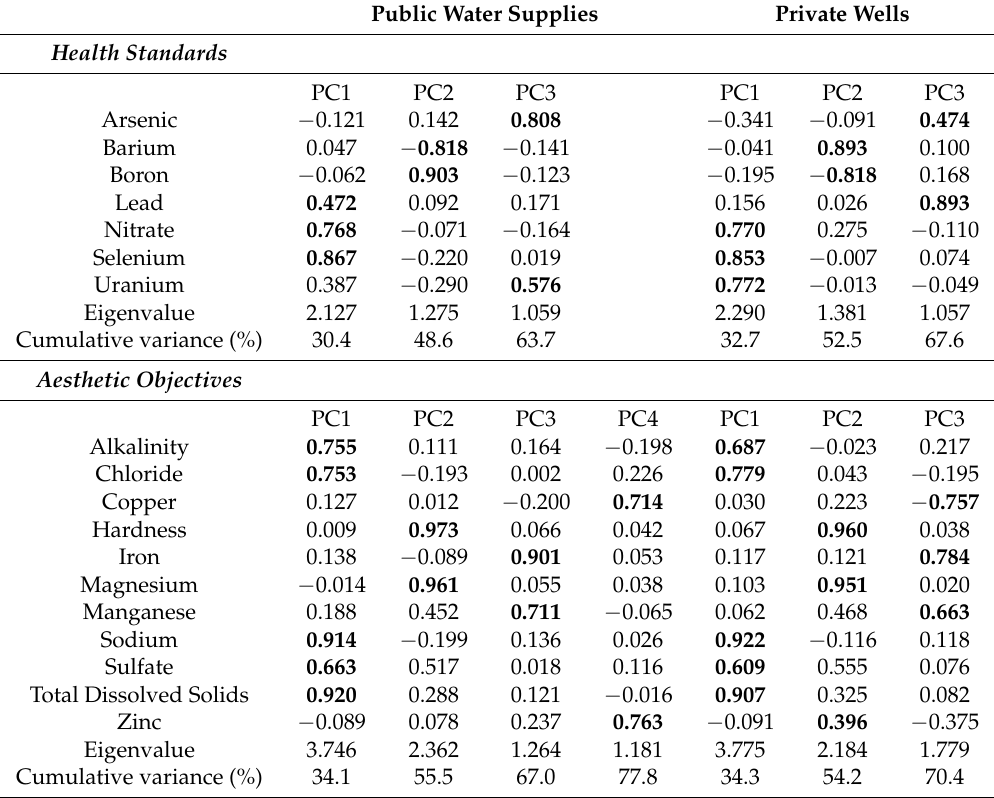
Table 4. Principal components analysis on public water supplies and private well water supplies: varimax rotated principal components patterns, eigenvalues and percent of variance explained for each retained component. The loadings in bold font indicate the principal component with the maximum loading for each measured